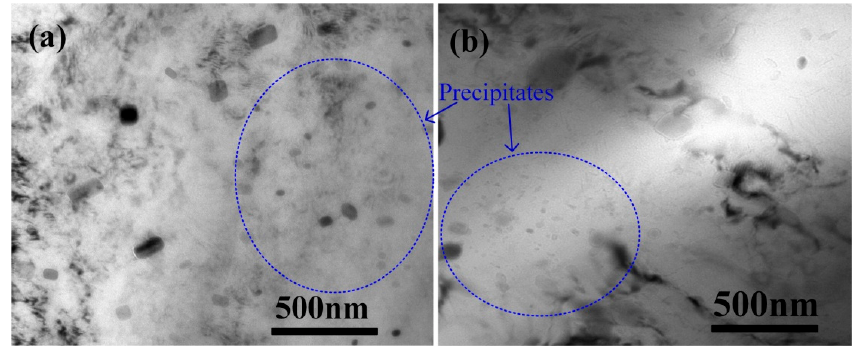
Figure 9. Transmission electron microscopy (TEM) micrograph of ( a ) WQ + CR; ( b ) RQ after 1-hour artificial aging preheated at 540 °C.